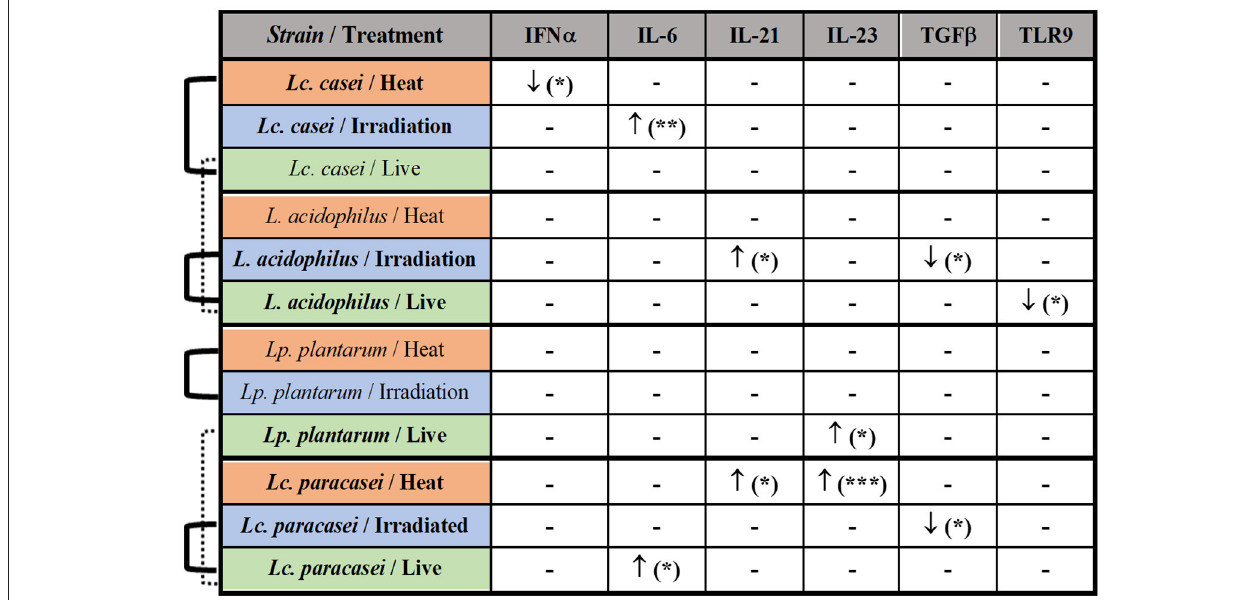
FIGURE 5 | Summary of the immune modulation exerted by immunobiotic and paraprobiotic LAB strains. LAB strains and respective treatments are listed in the first column. Strains highlighted in bold were able to induce a statistically significant difference in the up- ( ↑ ) or downregulation ( ↓ ) of the immune markers listed in the first row. Similarities in overall gene expression modulation, observed in heat maps hierarchical clustering, are indicated by connection lines on the left side of the table. Solid lines show similarity among different states of the same strain whereas the dashed line shows a similarity among live strains of different genera. * P ≤ 0.05, ** P ≤ 0.01 and *** P ≤ 0.001 were used to express the degree of